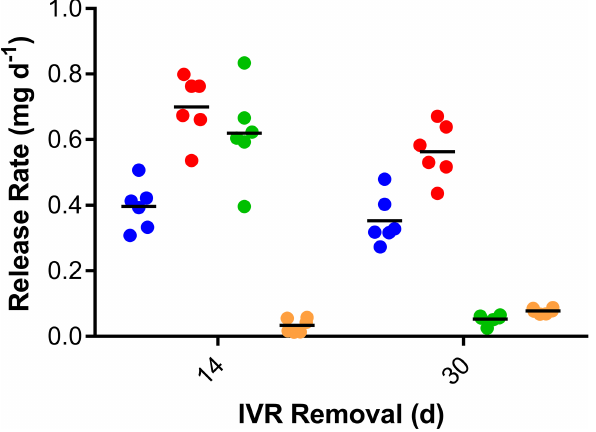
Fig 3. TAF2-ACV-ENG-EE pod-IVR in vivo daily drug releaserates based on residual drug measurements on used IVRs. Blue circles, TAF 2 ; red circles, ACV; green circles, ENG; orangecircles, EE. Horizontallines represent means.